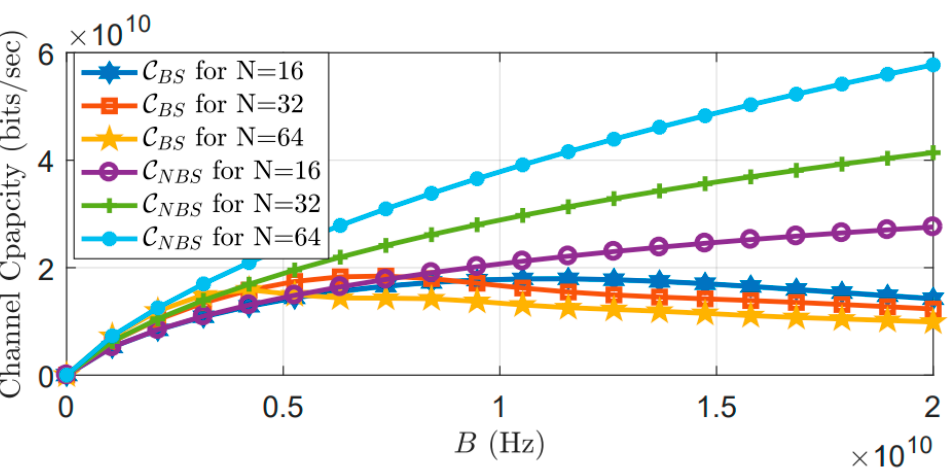
Figure 7. Capacity as a function of bandwidth with beam squint (CBS) and without beam squint (CNBS) [41].